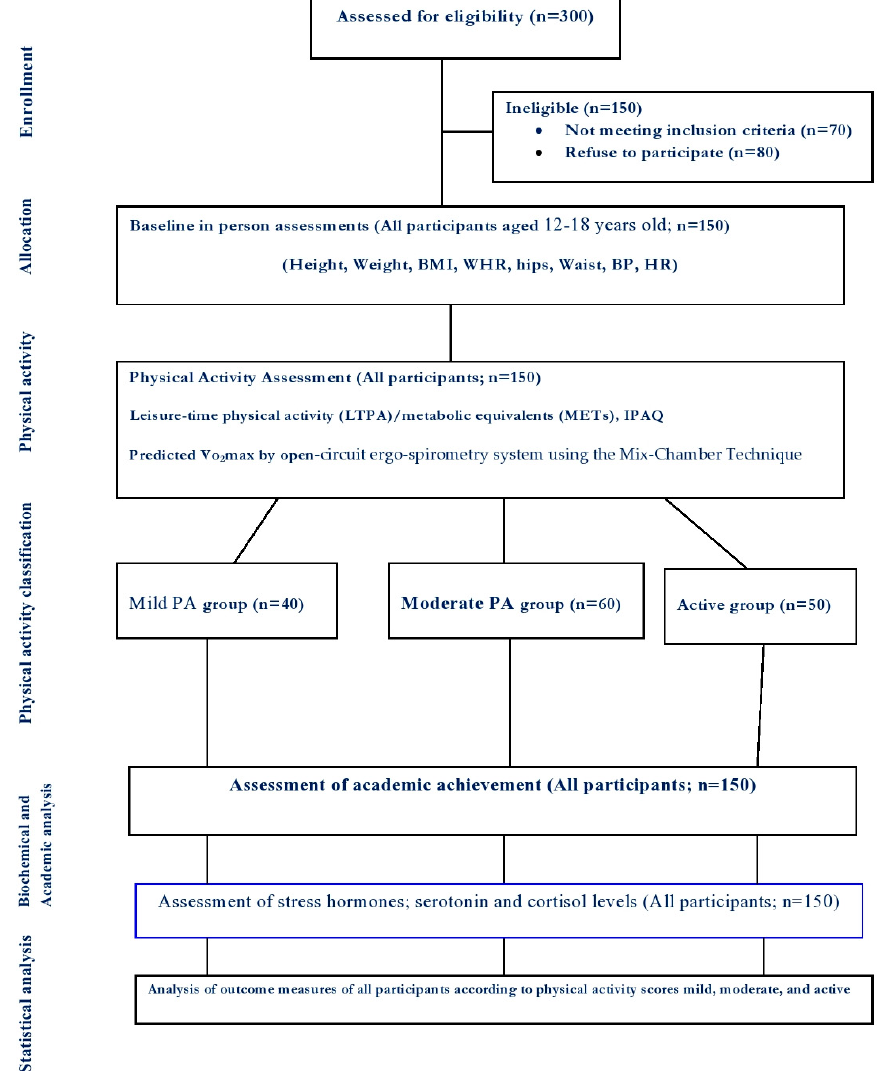
Figure 1. Outline of physical activity screening as well as associated assessments, LTPA: Leisure-time physical activity, METs: metabolic equivalents, IPAQ: International physical activity questionnaires, VO2 max, stress hormones, and academic achievements in all participants (n = 150).